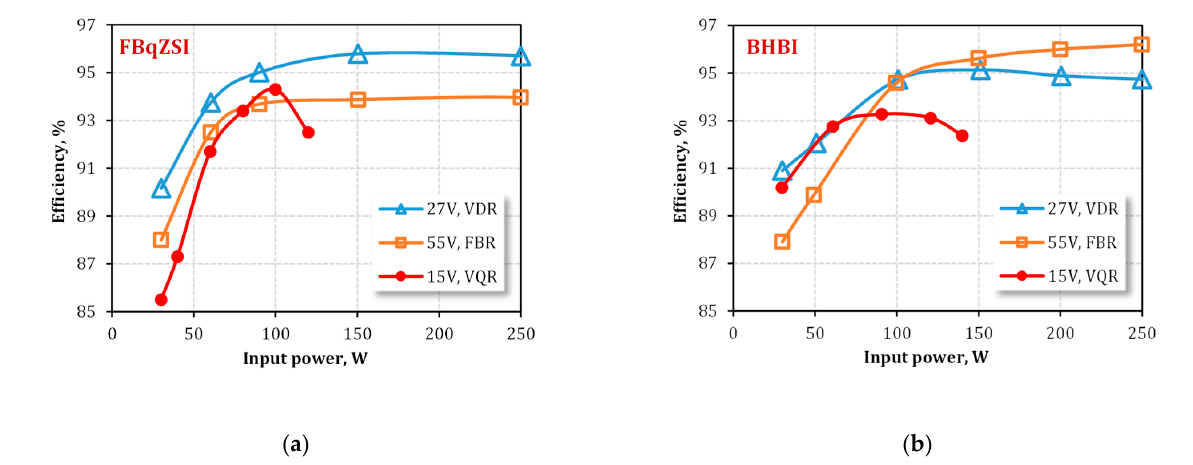
Figure 11. Experimental efficiency curves measured at different power levels for different input voltages for ( a ) FBqZSI and ( b ) BHBI.